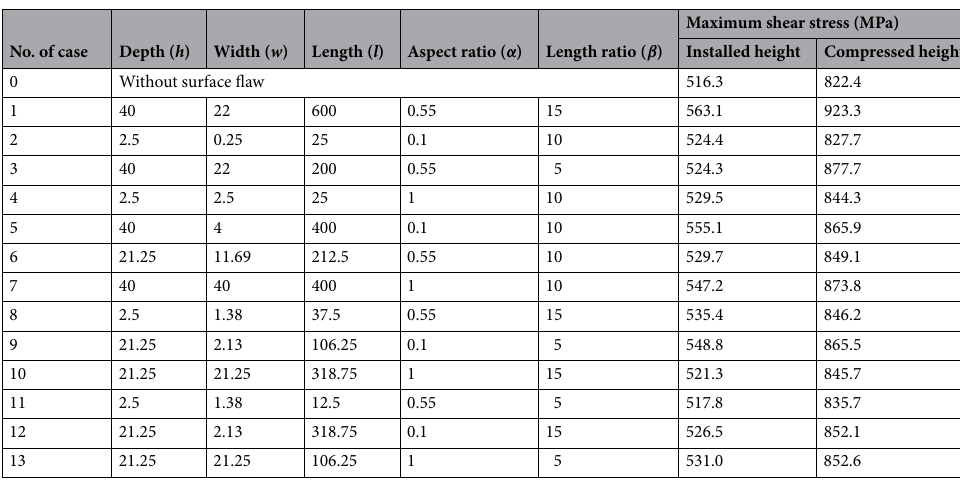
Table 5. Maximum shear stress obtained by strength analysis of automotive engine valve spring with a surface